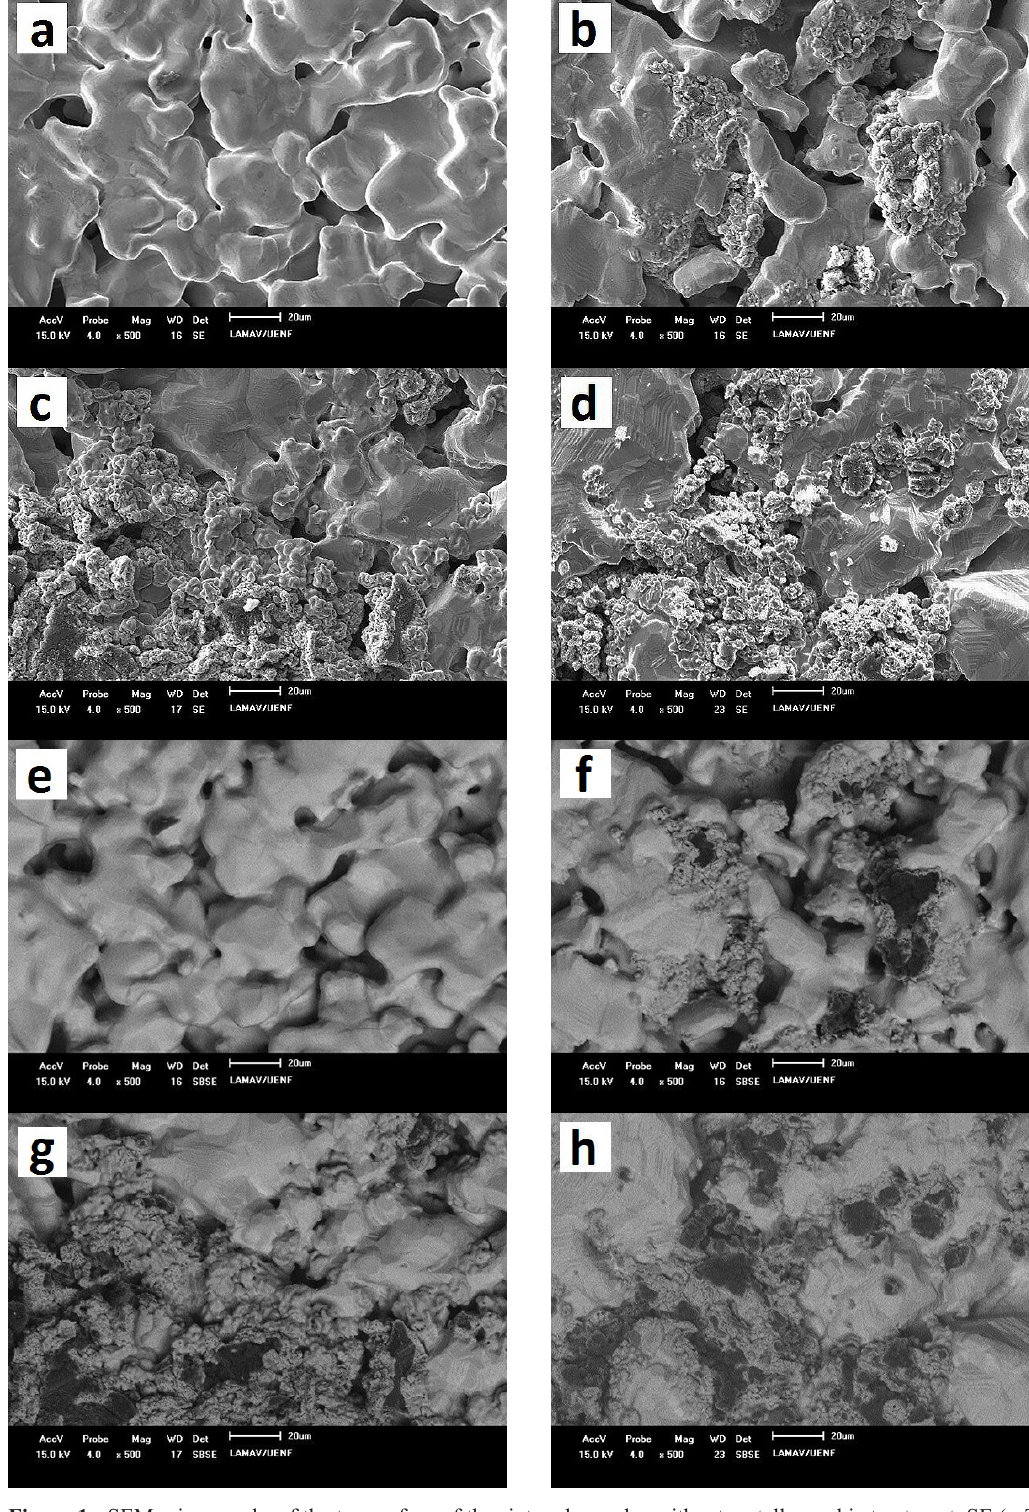
Figure 1 - SEM micrographs of the top surface of the sintered samples without metallographic treatment. SE ( a -Ti, b -Ti2D, c -Ti5D, d -Ti10D) and BSE ( e -Ti, f -Ti2D, g -Ti5D, and h -Ti10D). Magnification